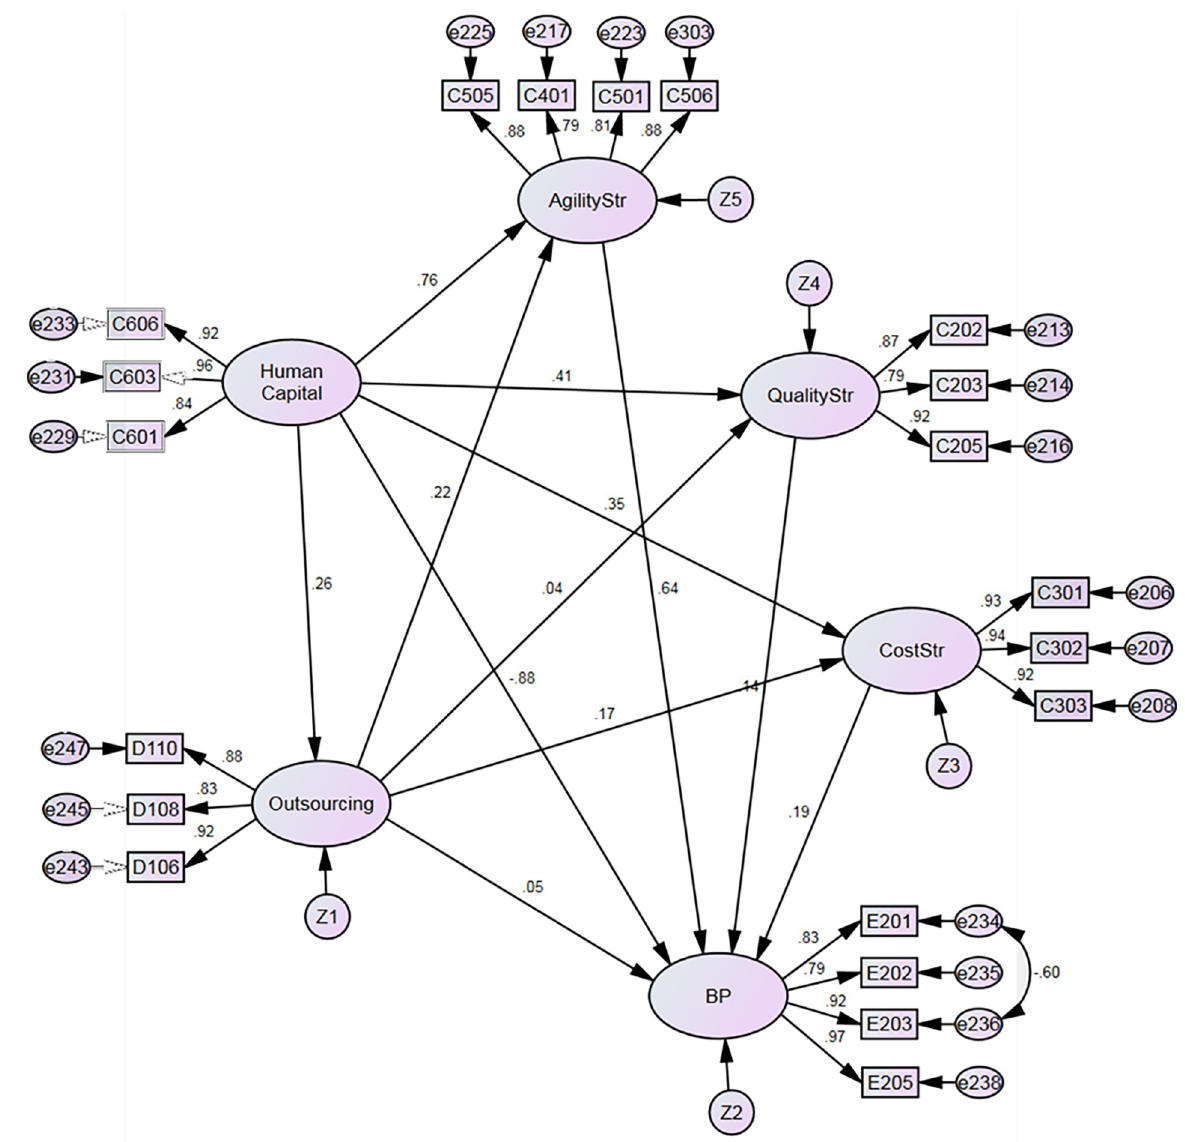
Fig 2. Structural model results for